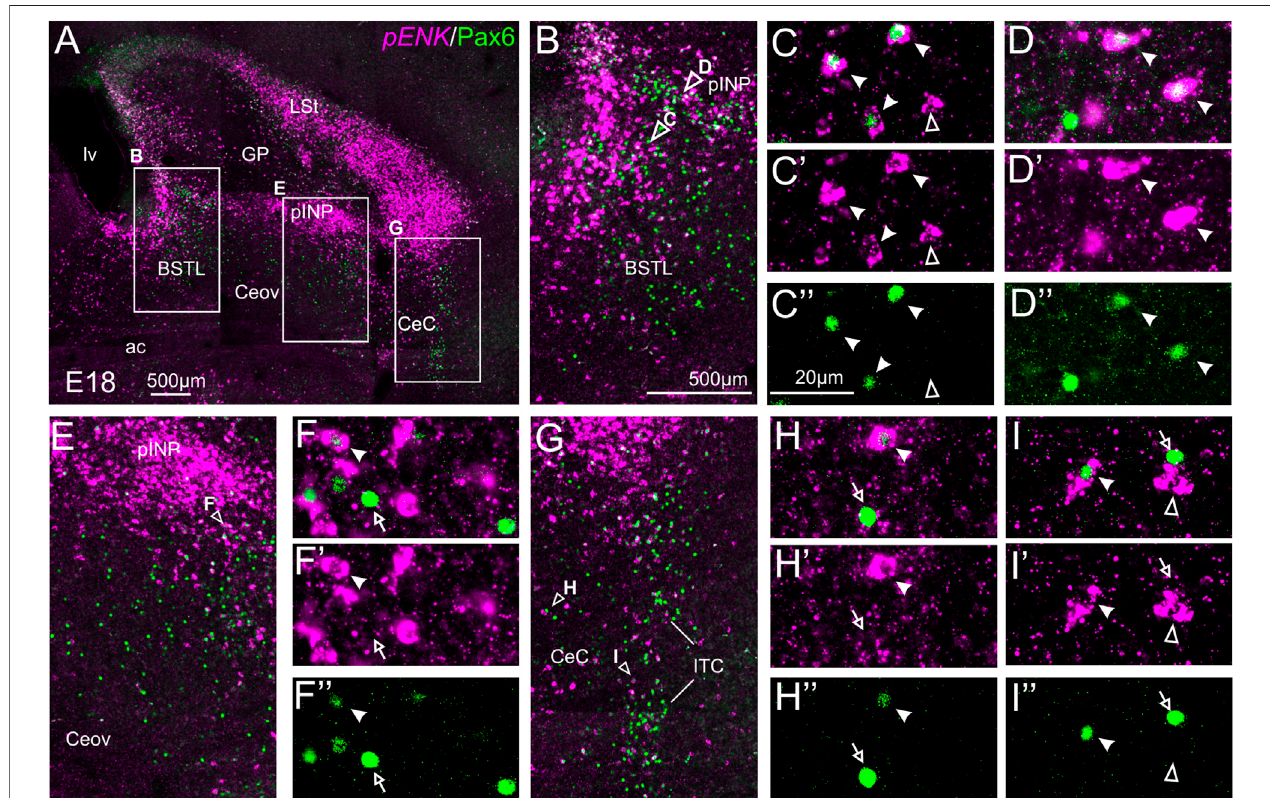
FIGURE 2 | Double fl uorescence labeling of pro-ENK ( pENK ) and Pax6 in the chicken central extended amygdala at E18. (A) General view (×10 objective) of the subpalliuminafrontalsectionattheleveloftheanteriorcommissure,processedforindirect fl uorescent insitu hybridizationfor pENK (magenta)andimmuno fl uorescence for Pax6 (green). (B,E,G) show ampli fi cations of the squared areas in (A) , at the level of the BSTL and medial pINP (B) , lateral pINP (E) or CeC and ITC (G) . Details (×40 objective, only one single z level of the confocal stack) of the areas pointed with arrowheads in (B,E) , and (G) are shown in (C – C 99 ) (for BSTL), (D – D 99 ) (for medial pINP), (F – F 99 ) (forlateralpINP), (H – H 99 ) (forCeC)and (I – I 99 ) (forITC)(mergedplusseparatemagentaandgreenchannelsareshown).Inthese details,cellscoexpressing pENK andPax6arepointedwitha fi lledarrowhead,cellssinglelabeledfor pENK arepointedwithanemptyarrowhead,whilecellssinglelabeledforPax6arepointedwith an empty arrow (only a few examples are pointed). See text for more details. For abbreviations see list. Scale bars: (A) = 500 μ m; (B) = 500 μ m [applies to (B,E,G) ]; (C 99 ) = 20 μ m [applies to (C – C 99 ,D – D 99 ,F – F 99 , H – H 99 ,I – I 99 ) ].